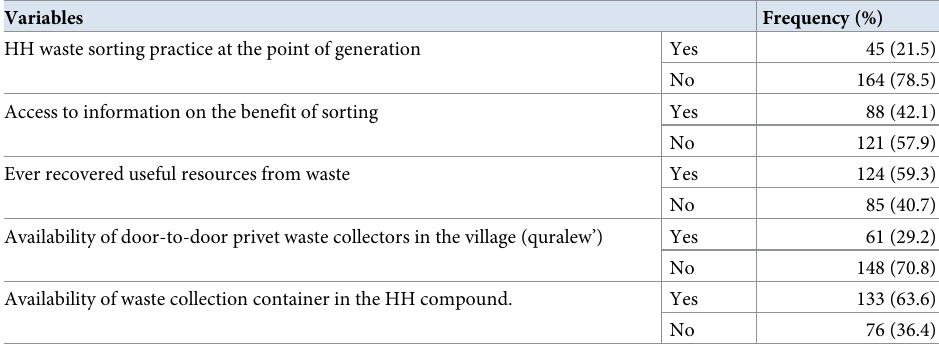
Table 2. Household waste Generation and sorting practice among households in Bedele town, 2021.